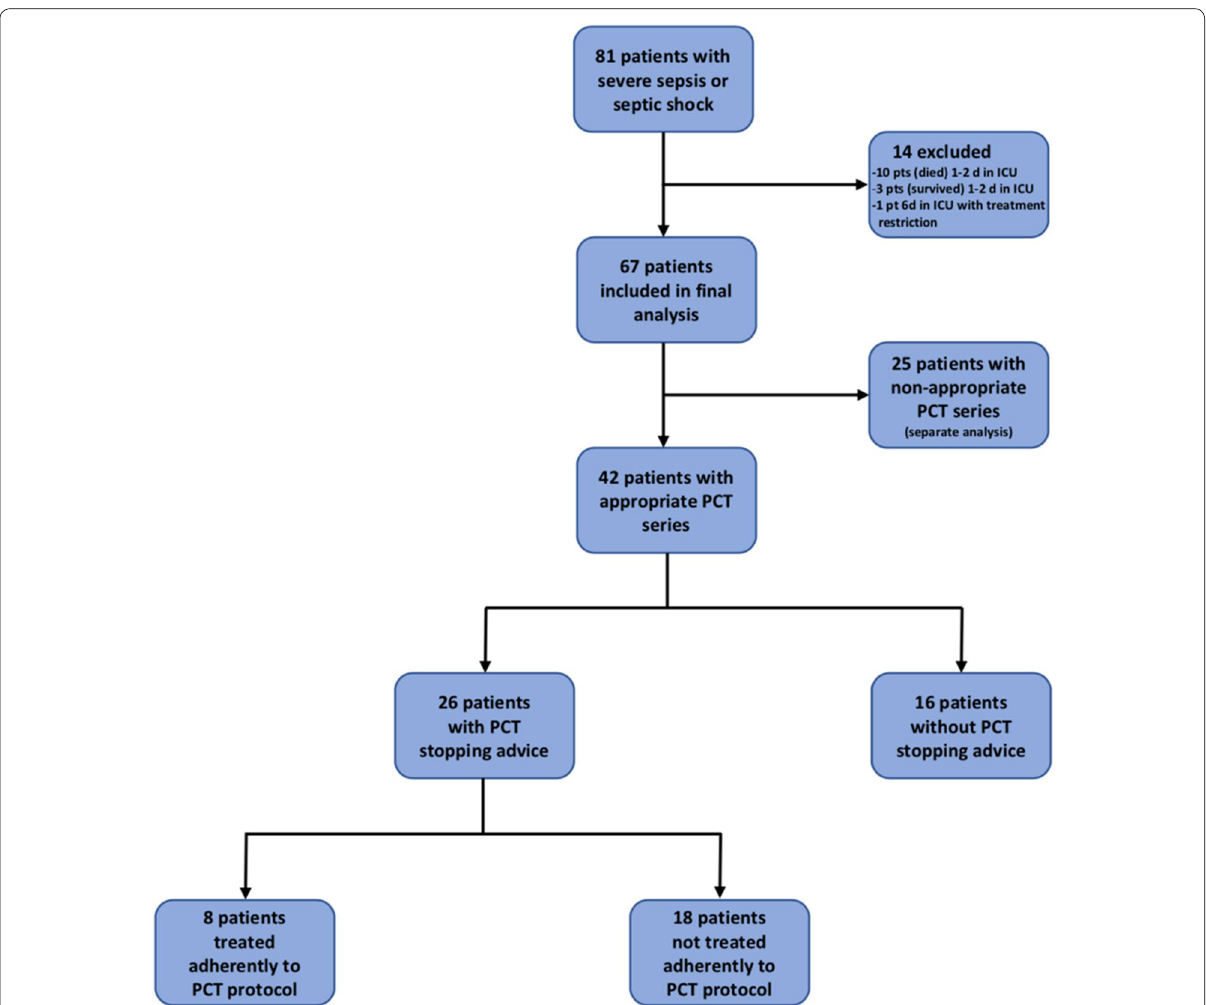
Fig. 2 Flow diagram of septic ICU patients and distribution to different subgroups of procalcitonin testing and protocol adherence. pt(s)